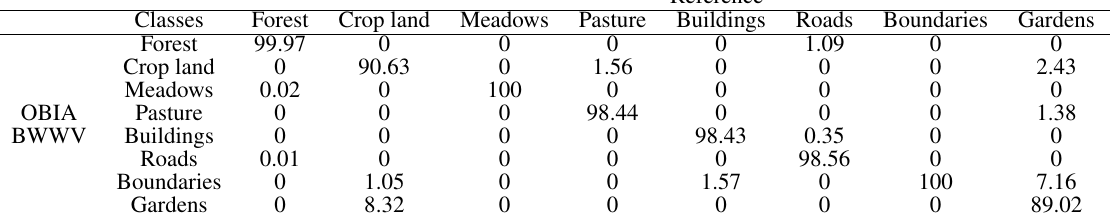
Table 6. Confusion matrix for OBIA Best Worst Weighted Vote (BWWV). Values are percentages of the reference test set (column-based normalization), producer accuracy can be read on diagonal